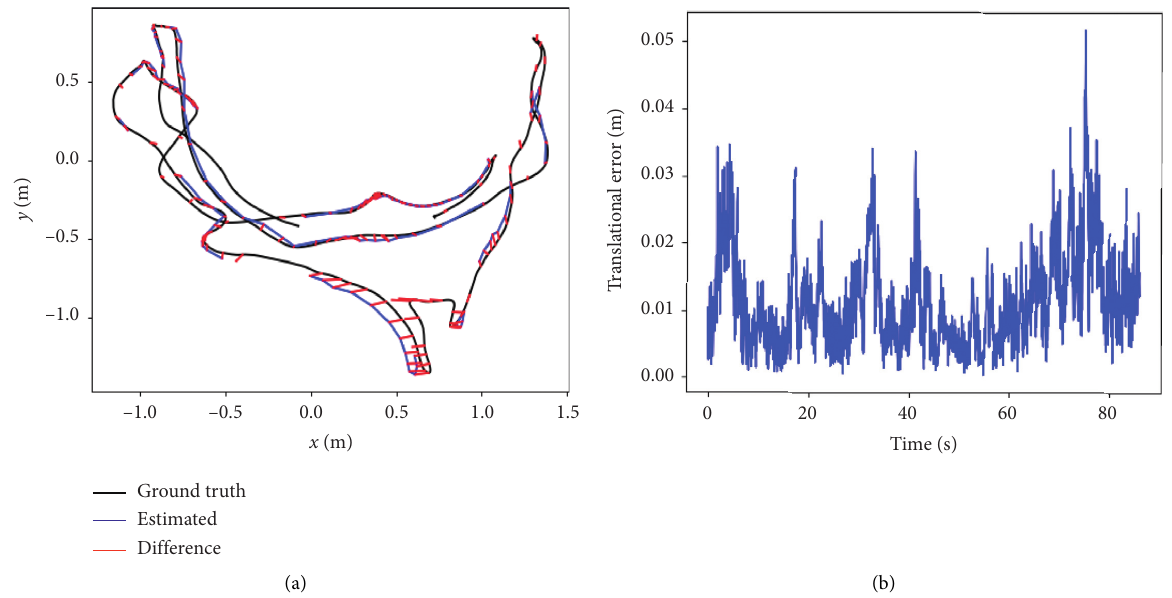
Figure 10: Error analysis of dataset freiburg1_xyz. (a) Absolute track error for construction of map. (b) Relative pose error for construction of map.